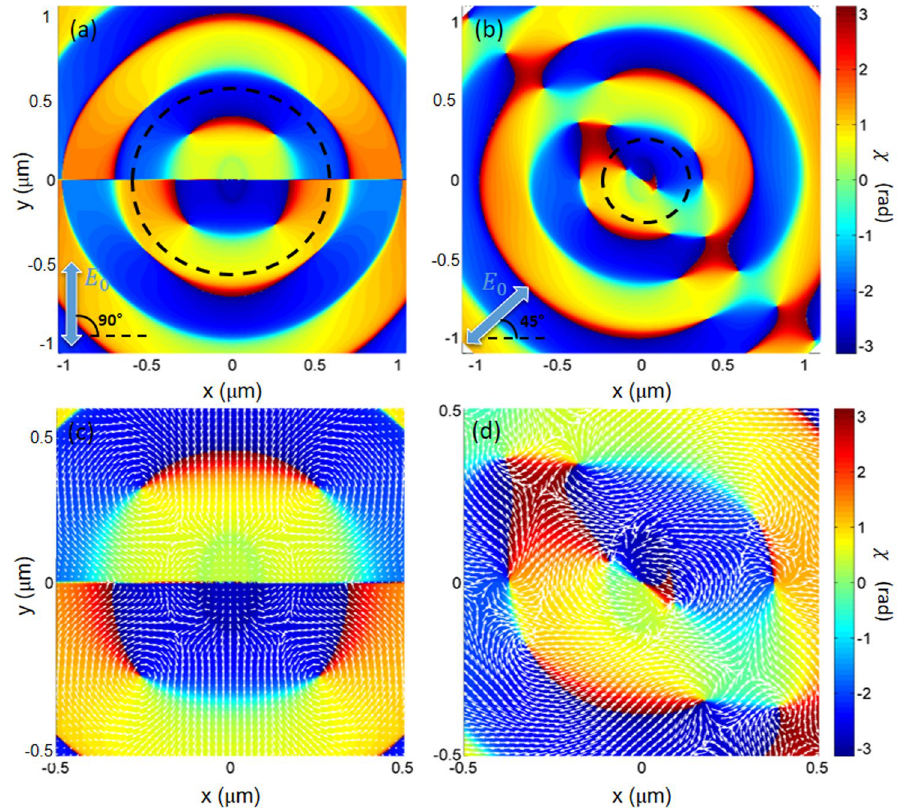
Figure 4. Numerical results: ( a ) Spatial distribution (2 μ m × 2 μ m) of the phase variation of the z-component of the total field calculated by FEM simulations at 2 nm from the Au surface for an incident polarization direction coincident with the major axis of the elliptical nanohole at normal incidence. The dashed black line encloses the region with the balance of total topological charge. ( b ) Spatial distribution (2 μ m × 2 μ m) of the phase variation of the z-component of the total field calculated by FEM simulations at 2 nm from the Au surface for an incident polarization direction rotated of 45° respect to the major axis of the elliptical nanohole at normal incidence. The dashed black line encloses the region with the unbalance of total topological charge. ( c ) Spatial distribution (1 μ m × 1 μ m) of the phase variation of the z-component of the total field calculated by FEM simulations at 2 nm from the Au surface for an incident polarization direction shifted of 45° respect to the major axis of the elliptical nanohole at normal incidence. ( c ) Spatial distribution (1 μ m × 1 μ m) of the phase variation of the z-component of the total field calculated by FEM simulations at 2 nm from the Au surface for an incident polarization direction coincident with the major axis of the elliptical nanohole at normal incidence. In figures ( c , d ), white arrows are the optical momentum vectors ( p 0 ) that evidence the formation of optical vortices around the phase